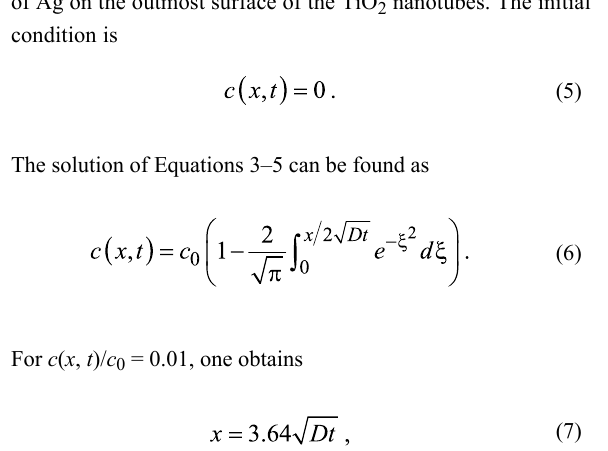
Equation 1 and Equation 2, one can note that the smaller the size of nanoparticle, the lower is the melting point. Using the parameters of h = 0.2898 nm [39], T m ( ∞ ) = 1234 K [40], S vib ( ∞ ) = 7 . 98 J mol − 1 ·K − 1 [38] in Equation 1, one obtains